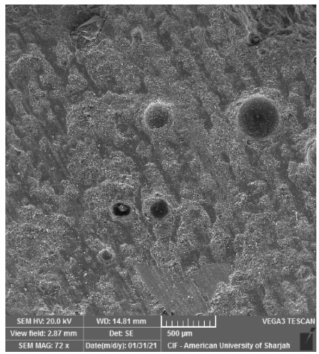
Figure 7. Entrained and entrapped air voids in RPC microstructure.